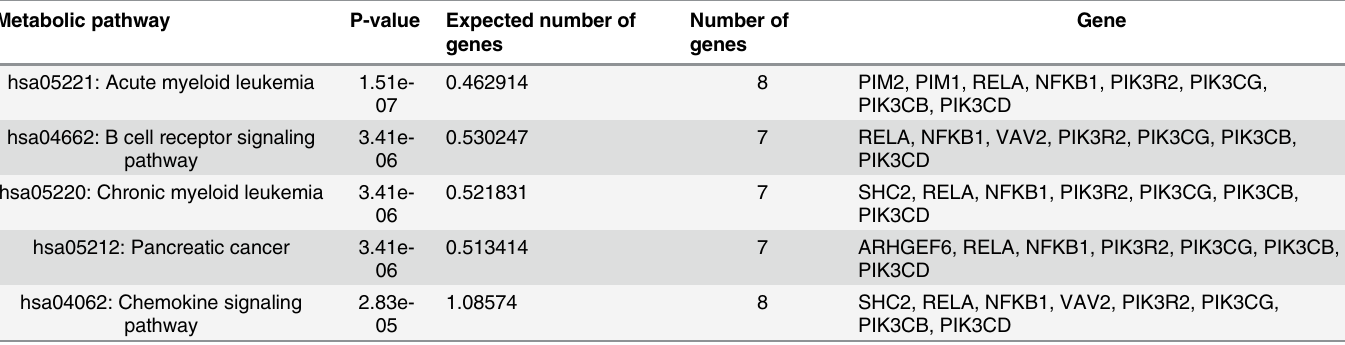
Table 6. Enrichment analysis of causal genes in